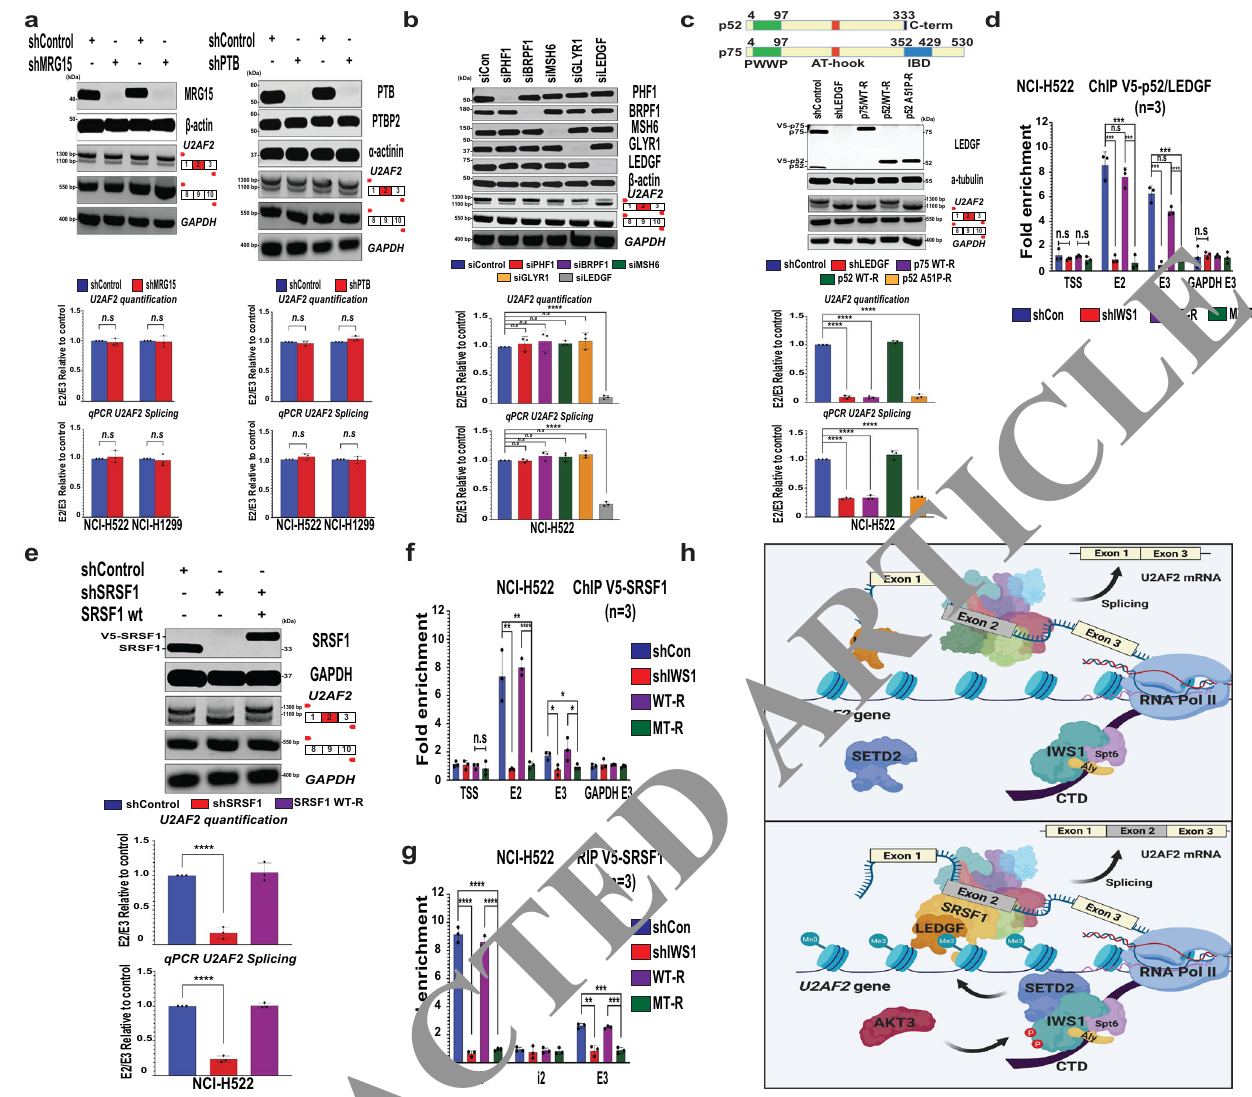
Fig. 4 The regulation of the alternative splicing of the U2AF2 exon 2 by IWS1 and IWS1 phosphorylation, depends on the p52 isoform of the H3K36me3 reader LEDGF and its splicing partner SRSF1. a (Upper panel) Lysates of the indicated cells were probed with antibodies, as shown. RT-PCR addressing exon 2 U2AF2 splicing in the same cells. (Middle and Lower Panels) U2AF2 E2/E3 ±SD, was determined by quanti fi cation of the RT-PCR results and by qRT-PCR. b (Upper Panel) Lysates of NCI-H522 cells transfected with the indicated siRNAs, probed with antibodies, as shown. RT-PCR addressing exon 2 U2AF2 splicing. (Middle and Lower Panels) U2AF2 E2/E3 ±SD, was determined by quanti fi cation of the RT-PCR results and by qRT-PCR. c (Upper panel) Domains of the p52 and p75 LEDGF isoforms (see Ferris et al., 2010 50 ). (Middle panel) Western blot of the indicated NCI-H522 cells, probed for LEDGF expression and RT-PCR, addressing U2AF2 exon 2 splicing in the same cells. (Lower panels) U2AF2 E2/E3 ratio ±SD, was determined by quanti fi cation of the RT-PCR results and by qRT-PCR. d ChIP of p52/LEDGF in NCI-H522 cells, transduced with V5-p52/LEDGF. Mean fold enrichment in p52/LEDGF binding (anti-V5 IP, vs IgG control IP) to the indicated U2AF2 regions±SD. V5-p52/LEDGF expression, in fi gure S5G. e (Upper panel) Immunoblotting, showing SRSF1 expression in the indicated NCI-H522 cells. RT-PCR addressing U2AF2 exon 2 splicing. (Lower panels) U2AF2 E2/E3 ratio ±SD, was determined by quanti fi cation of the RT-PCR results and by qRT-PCR. f SRSF1 ChIP in the indicated V5-SRSF1-transduced NCI-H522 cells. Mean fold enrichment in SRSF1 binding (anti-V5 IP, vs IgG control IP) to the indicated U2AF2 regions±SD. V5-SRSF1 expression in Supplementary fi gure S6b. g RIP, addressing SRSF1 binding to U2AF2 RNA in panel f cells. Mean fold enrichment in SRSF1 binding (anti-V5 IP, vs IgG control IP) in the indicated U2AF2 regions ±SD. All assays were done, using three biological replicates, in triplicate. n.s non-signi fi cant, * p < 0.05, ** p < 0.01, *** p < 0.001, **** p < 0.0001 (one-sided unpaired t -test). h Phosphorylation of IWS1 recruits SETD2 in CTD of RNA Pol II. SetD2 trimethylates histone H3K36 co-transcriptionally. p52/ LEDGF and its partner SRSF1, bind histone H3K36me3 promoting exon 2 inclusion in the mature U2AF2